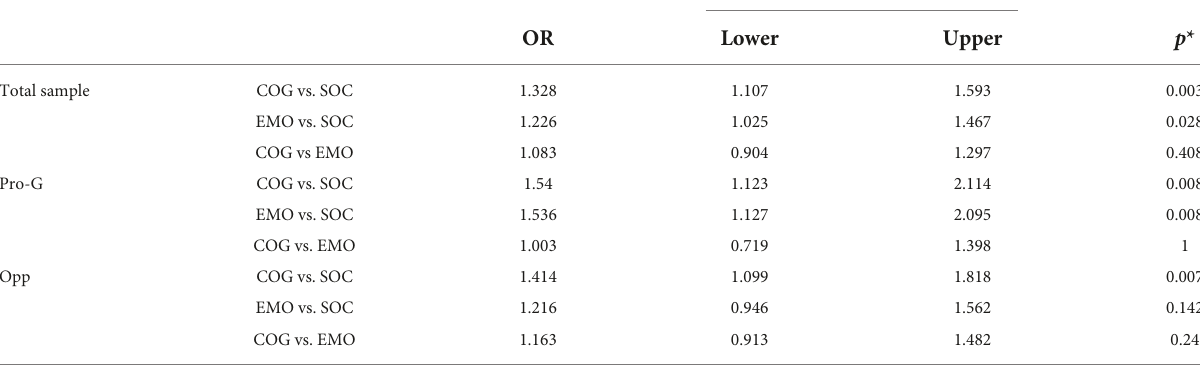
TABLE 7 Comparative effect of messages in eliciting the highest response category (complete